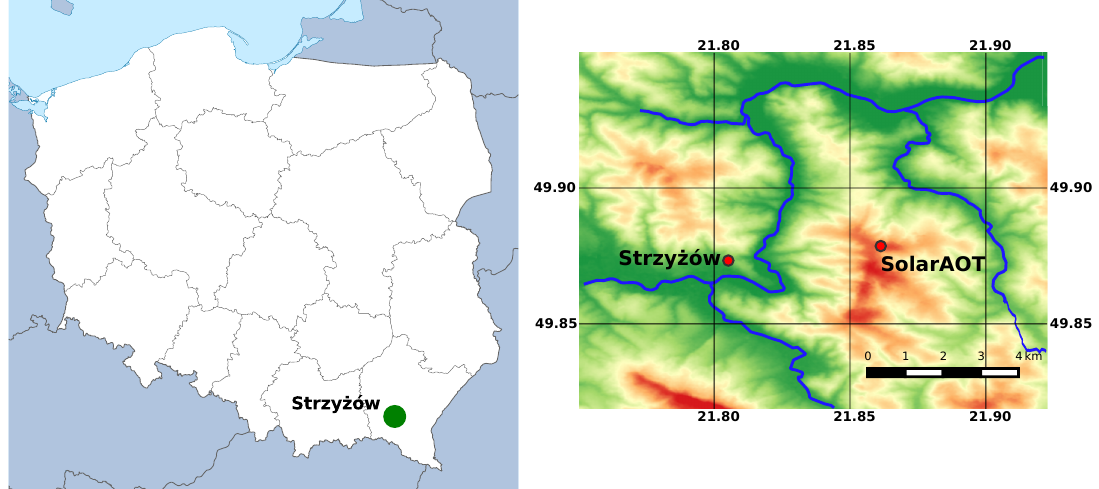
Figure 1. Location of the Poland-AOD (network) station in